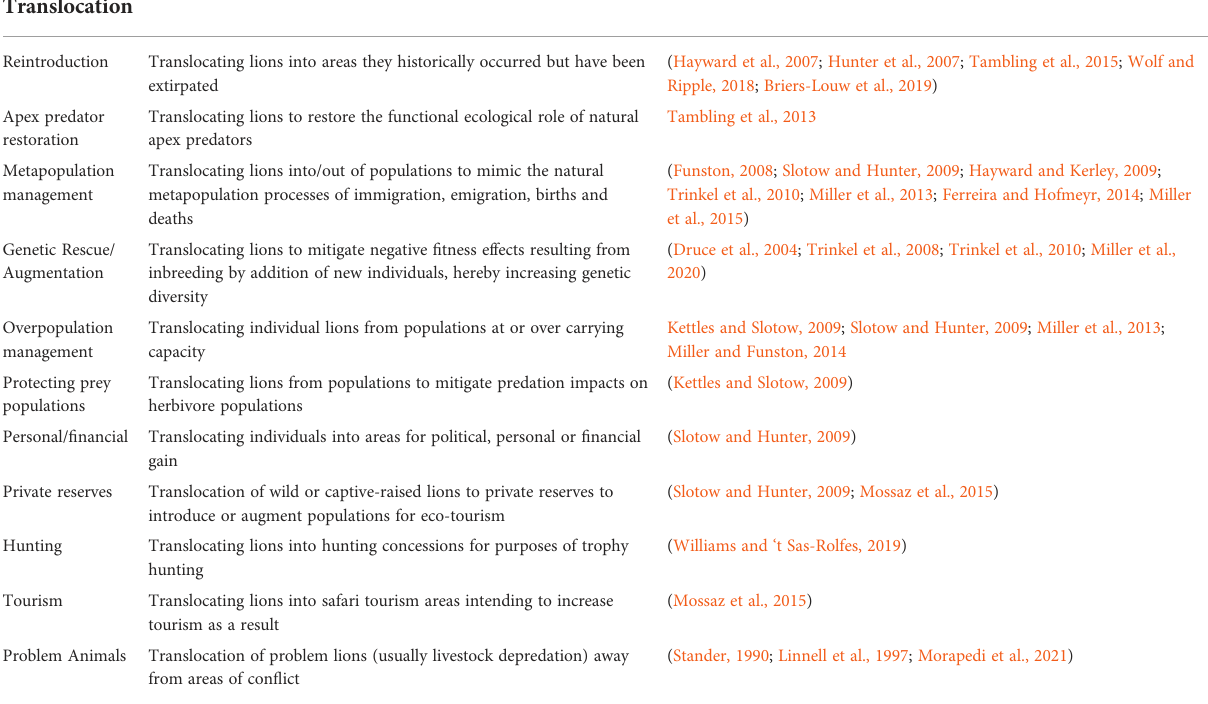
TABLE 1 Primary reasons for lion translocations. There is a wide array of rationales for translocating lions, encompassing a wide range of ecological, management, fi nancial and personal objectives. Rationale for